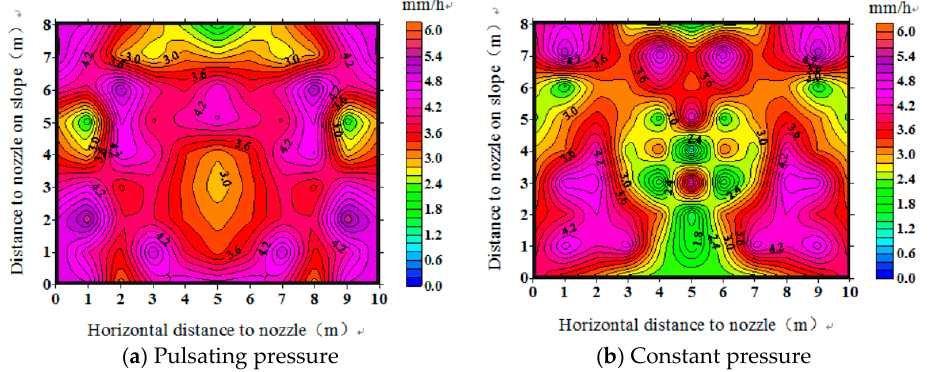
Figure 9. Overlapped water distribution for multiple sprinklers.